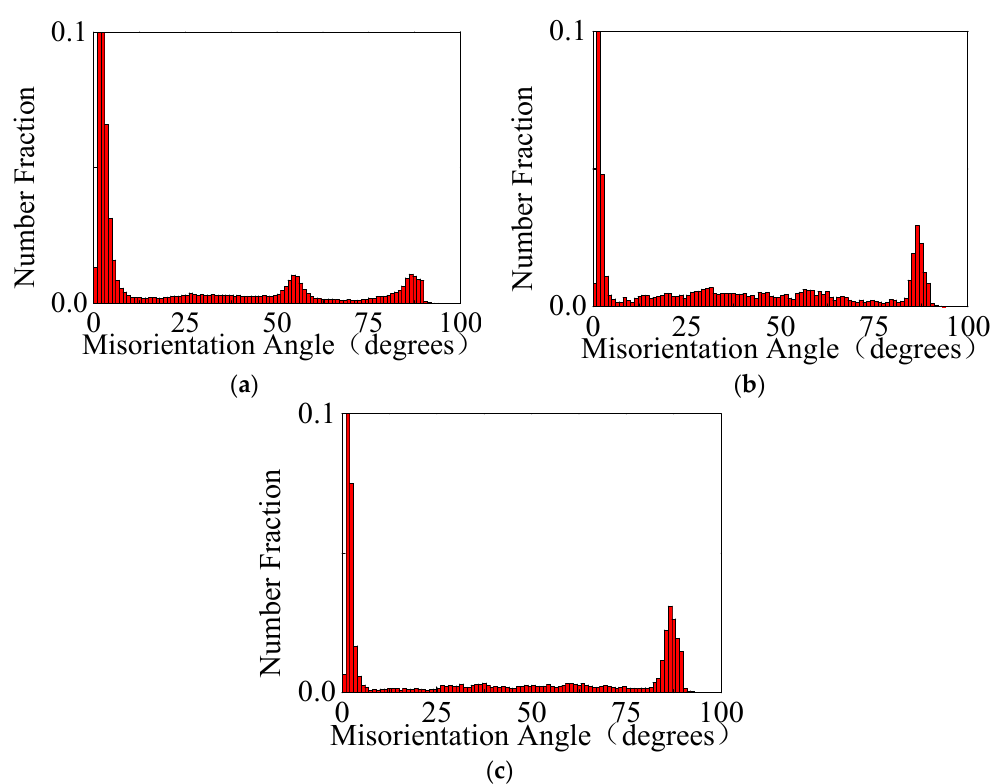
Figure 5. Misorientation angle distribution of impacted wrought AZ31 ‐ TD alloy: ( a ) 20 °C, ( b ) 150 °C, ( c ) 250 °C.